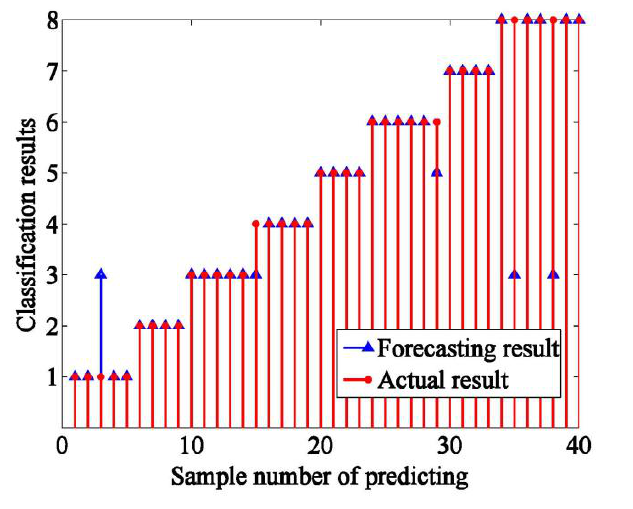
Figure 10. Classification performance of PNN network based on PNN.